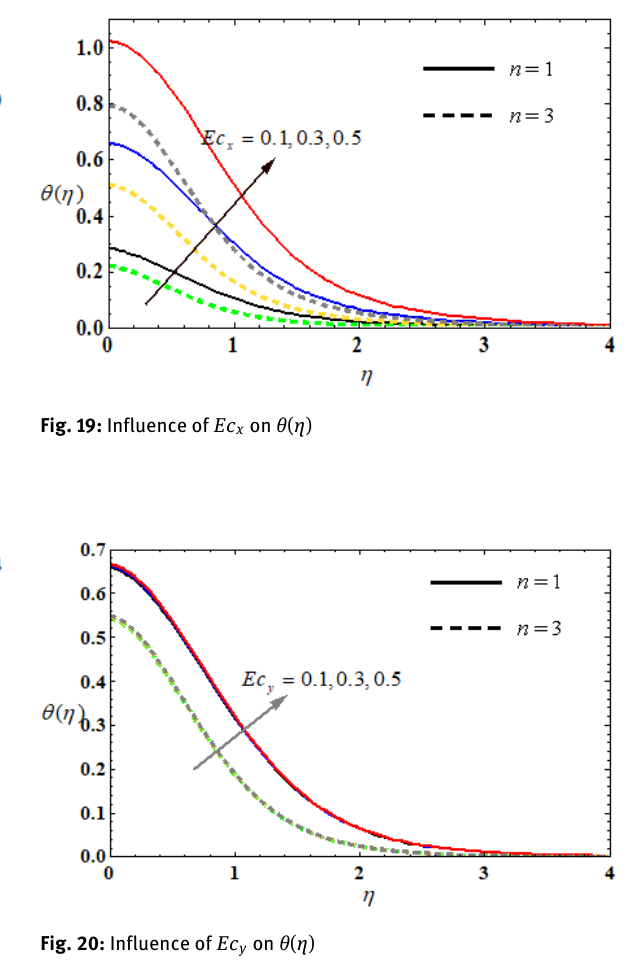
Fig. 20: Influence of Ec y on θ ( η